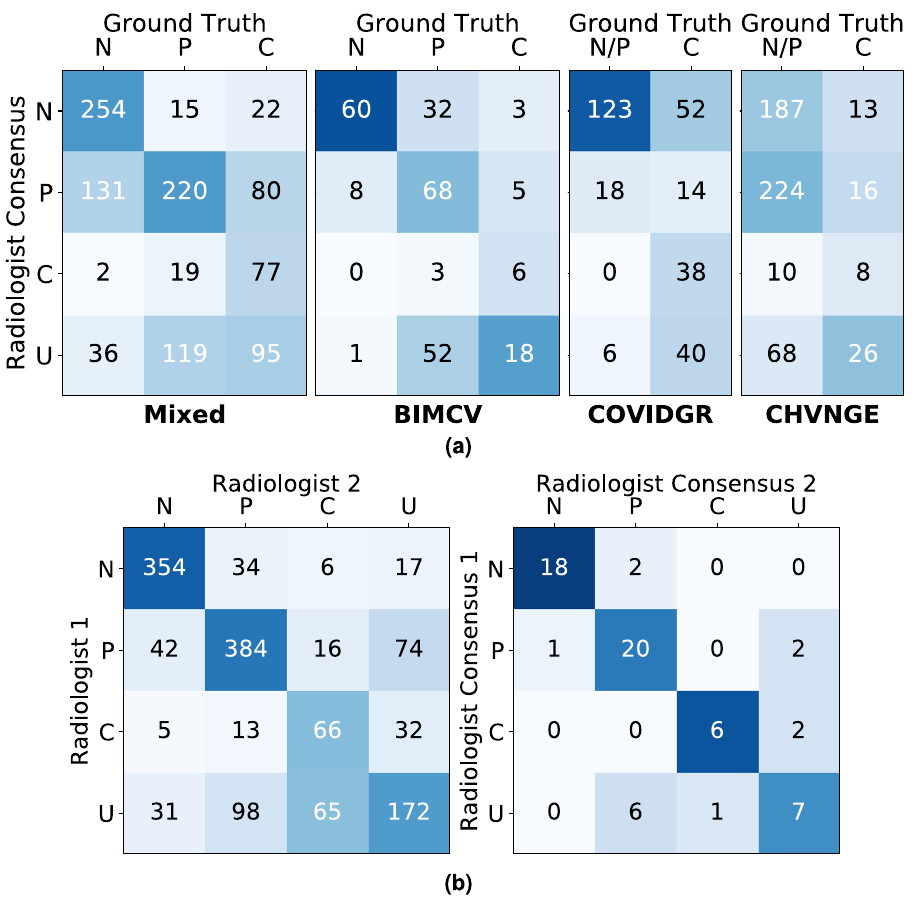
Figure 3. Confusion matrices between ground truth labels and radiologist annotations. ( a ) Comparison between ground truth and radiologists’ consensus on each dataset; ( b ) Inter- and intraobserver variability across all datasets (left and right respectively). N - Normal ; P - Not indicative of COVID-19 (pathological) ; C - Indicative of COVID-19 ; U - Undetermined . Cases annotated as Compromised are not shown. Color intensity corresponds to the percentage of cases within each column.